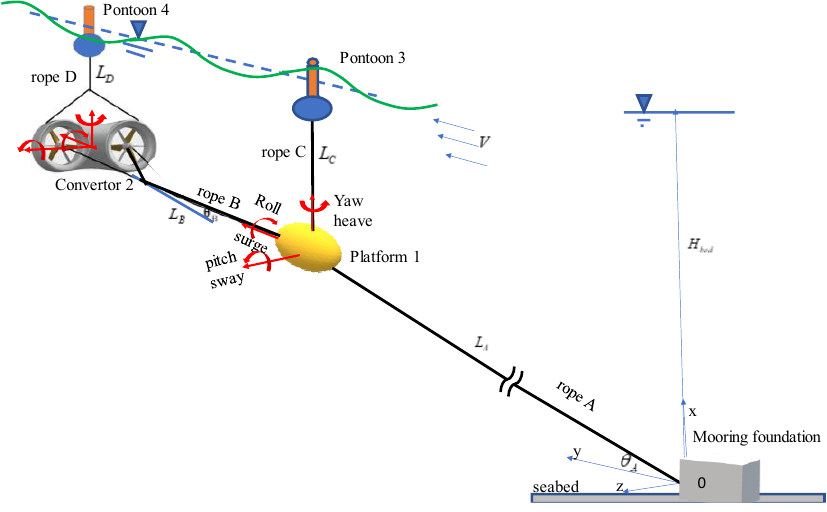
Figure 1. Configuration of the mooring system of ocean energy convertor.